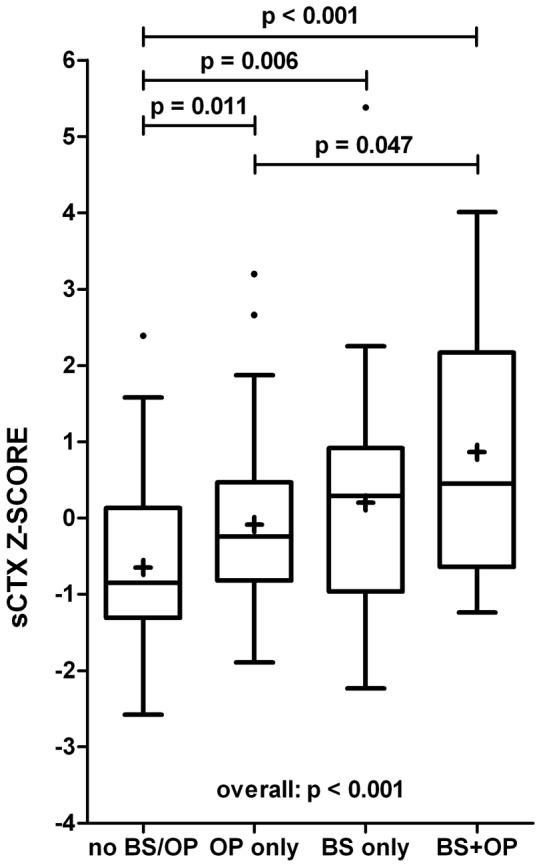
Bone resorption marker sCTX in AS patients with complete bridging, low BMD or both.Box-and-whisker plots (Tukey): boxes indicate medians with interquartile ranges;+indicate means; whiskers indicate 1.5 times the interquartile distances; · indicate outliers. BS: complete bridging, OP: low BMD.